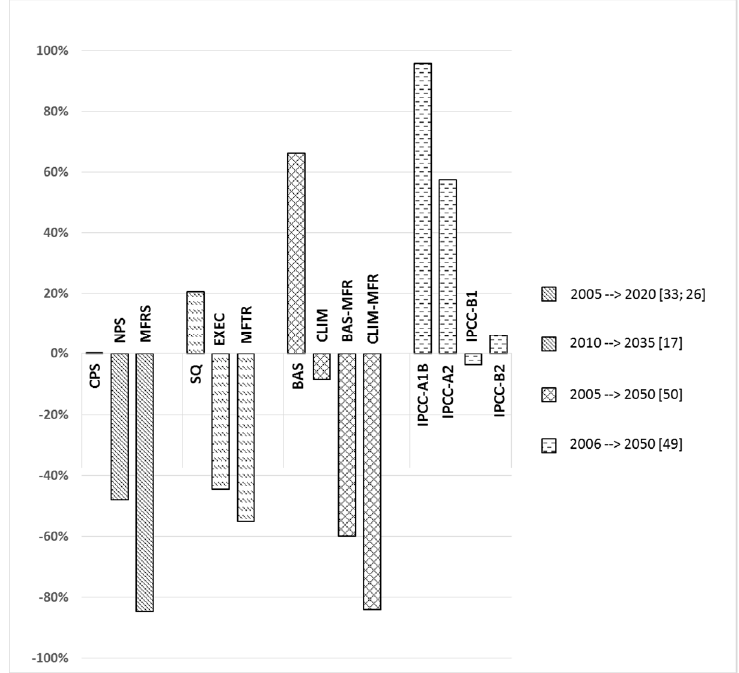
Figure 1. The estimated global change in anthropogenic mercury emissions under various scenario developments (relative to their base year).